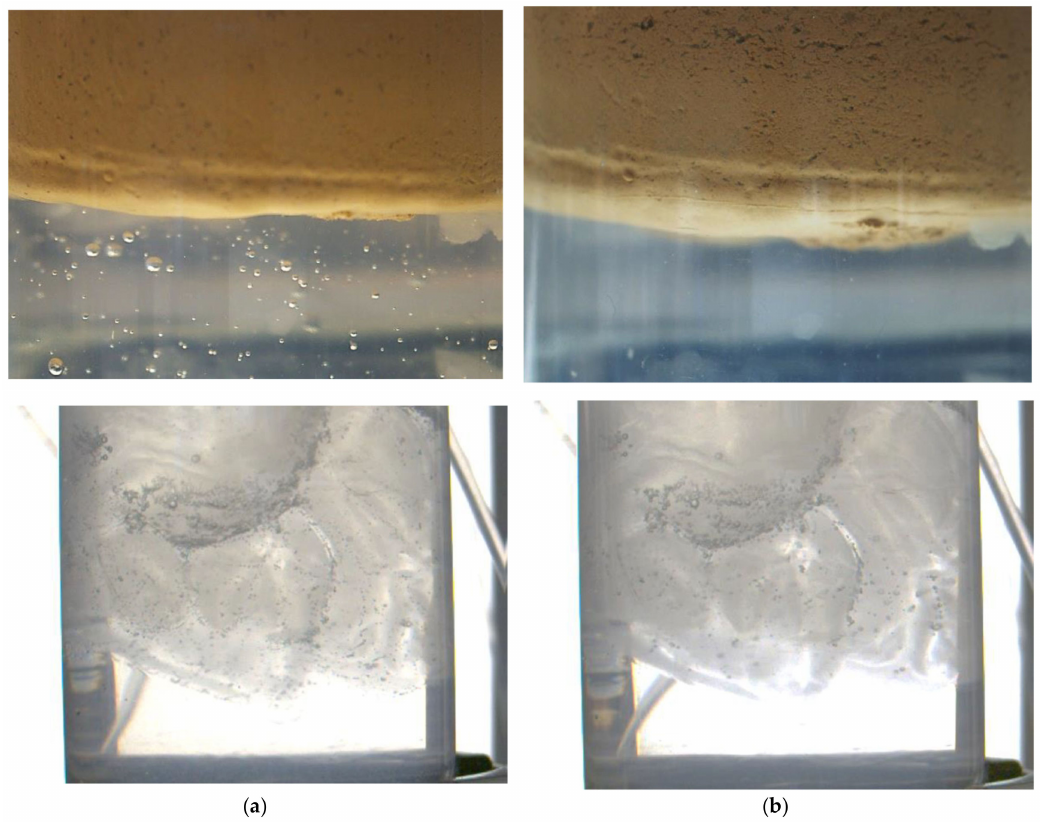
Figure 11. Picture of the laponite gel pill and model drilling fluid interface (upper picture), and brine and gel pill interface (bottom) for the vertical tests, ( a ) initially and ( b ) after 24